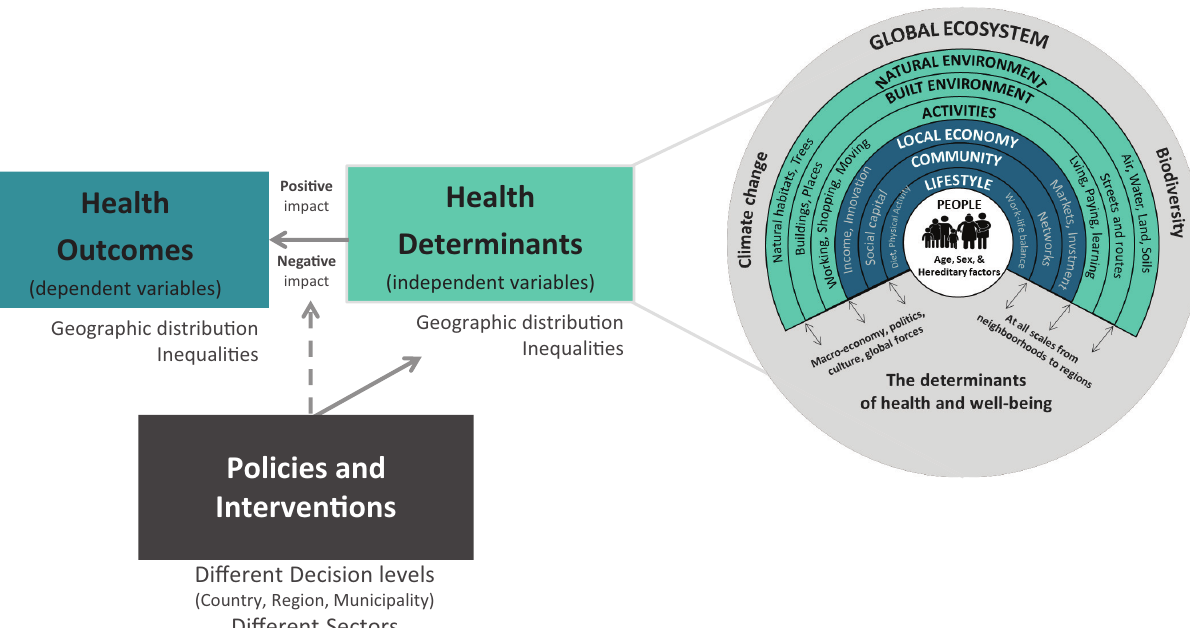
Figure 1. The population health approach considering the model of the main determinants of health. Source: Authors’ work adapted from Barton and Grant (2006), Dahlgren and Whitehead (1991, 2006), and Kindig and Stoddart (2003).